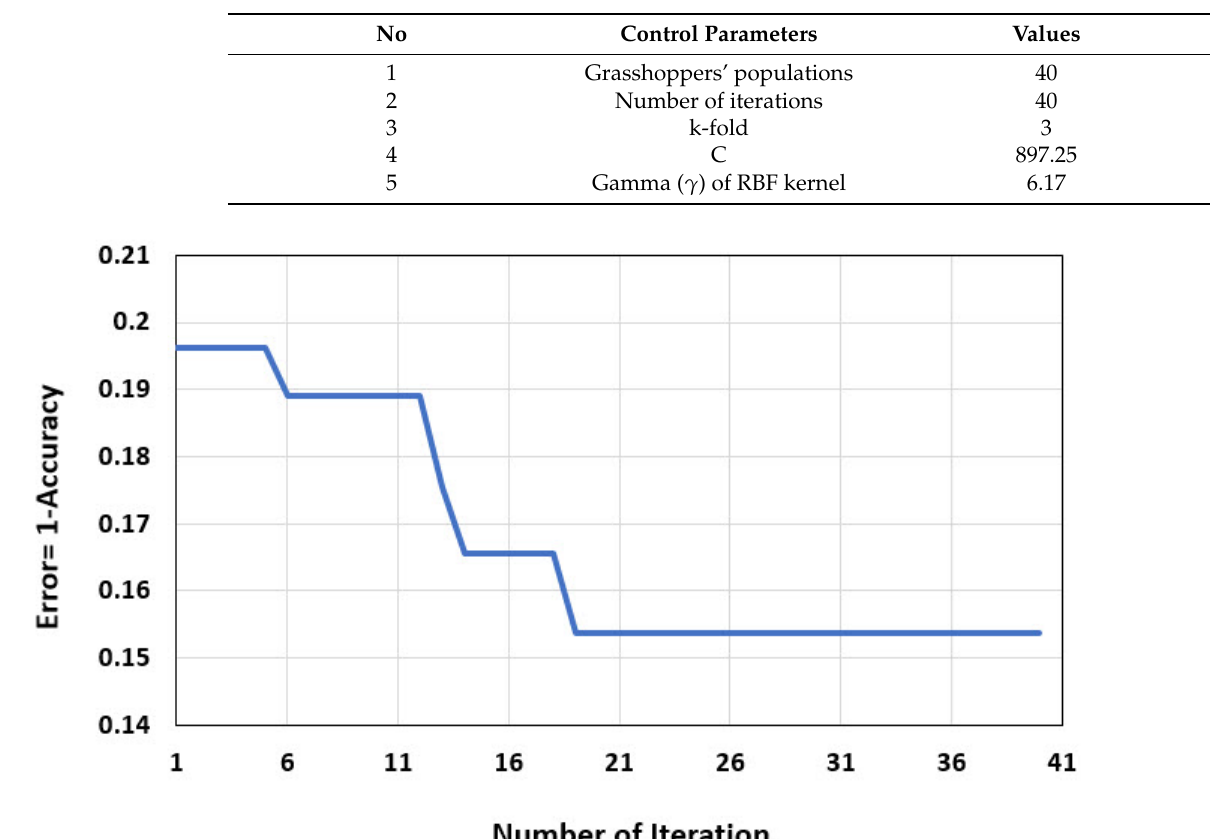
Figure 7. Comparison between the best GMDH and GOA-SVM models for training and testing ac- curacies.